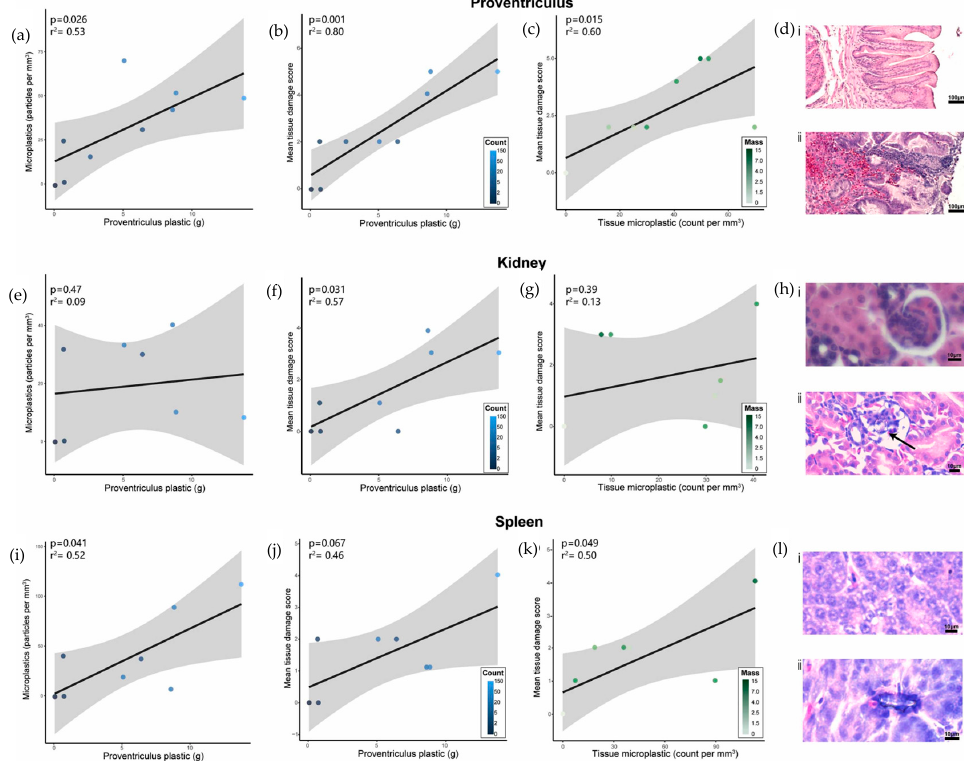
Figure 11. The mass of proventriculus microplastics (>1 mm) correlates with organ microplastics (<1 mm) and organ pathology. Inserts ( a , e , i ): The correlation between the mass of proventriculus microplastics (grams) with tissue microplastics identified through histology in the proventriculus ( a ), kidney ( e ), and spleen ( i ). Inserts ( b , f , j ): The correlation between the mass of proventriculus microplastics with mean tissue pathology score (0–5) in the proventriculus ( b ), kidney ( f ) and spleen ( j ). Inserts ( c , g , k ): The correlation between the tissue microplastics with mean tissue pathology score (0–5) in the proventriculus ( c ), kidney ( g ), and spleen ( k ).Inserts ( d , h , l ): Histological examples of healthy tissue (i) and tissue pathology (ii) in the proventriculus (( d ), inflammation and hemorrhage; scalebar 100 μ m), kidney (( h ), collapsed glomerus around microplastic (arrow), scalebar ( μ m), and spleen. Figure reproduced from Ref. [84] under the Creative Commons Attribution License.